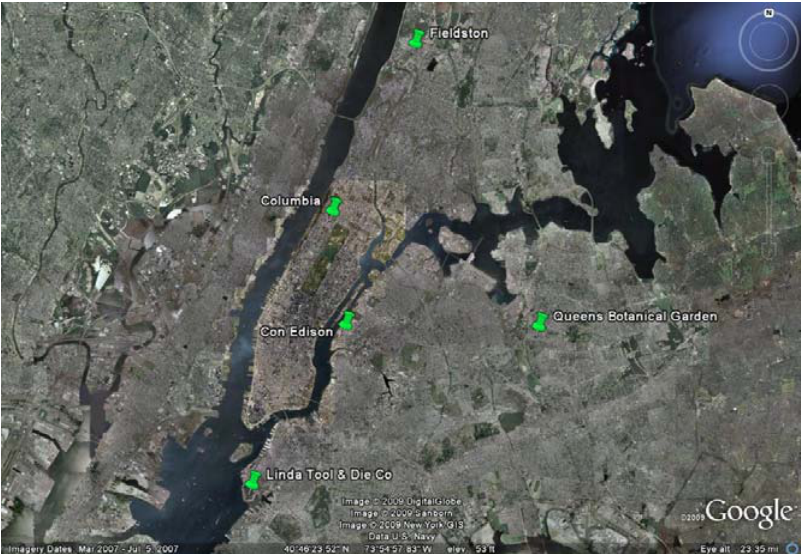
Figure 2. Location map showing research stations that currently comprise our green roof meteorological network. The green roof photographs shown in Figures 1a and 1b correspond to the “Fieldston” and “Columbia” map locations respectively. These two stations are separated by a distance of ~10 km. Three of our research stations are extensive green roofs (Fieldston, Columbia, Con Ed) with medium depths of 10-cm or less. The two other stations are semi-intensive with medium depths of 15-cm or